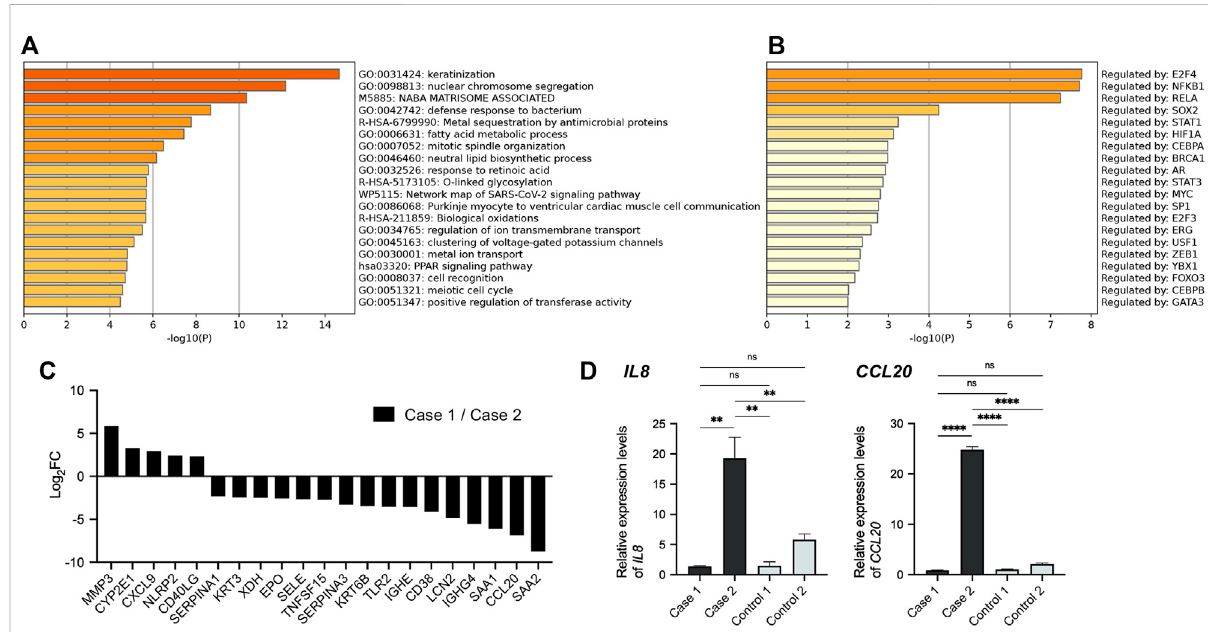
FIGURE 4 Comparison of transcriptional pro fi les among HHD patients. (A) GO terms related to the gene sets which had fi ve-fold changes between HHD patients. (B) TRRUST analysis revealed the involvement of NFKB1 and RELA. (C) Expression pro fi le of NF- κ B target genes in HHD patients. Each bar represents the ratio of expression level in case 1 to that in case 2 for indicated gene. (D) Gene expression levels of IL8 and CCL20 in whole skin samples. Statistical signi fi cance was calculated using one-way ANOVA with multiple comparisons test. Error bars represent SD. ** p < 0.01, **** p < 0.0001; ns, not signi fi cant.